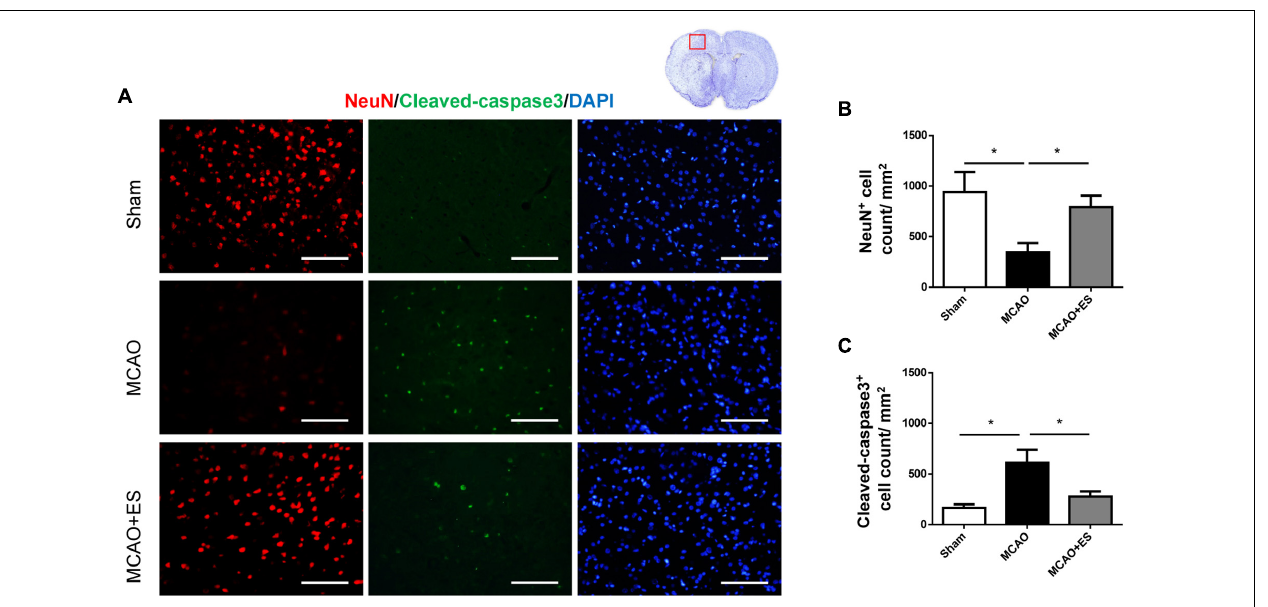
Frontiers in Aging Neuroscience |